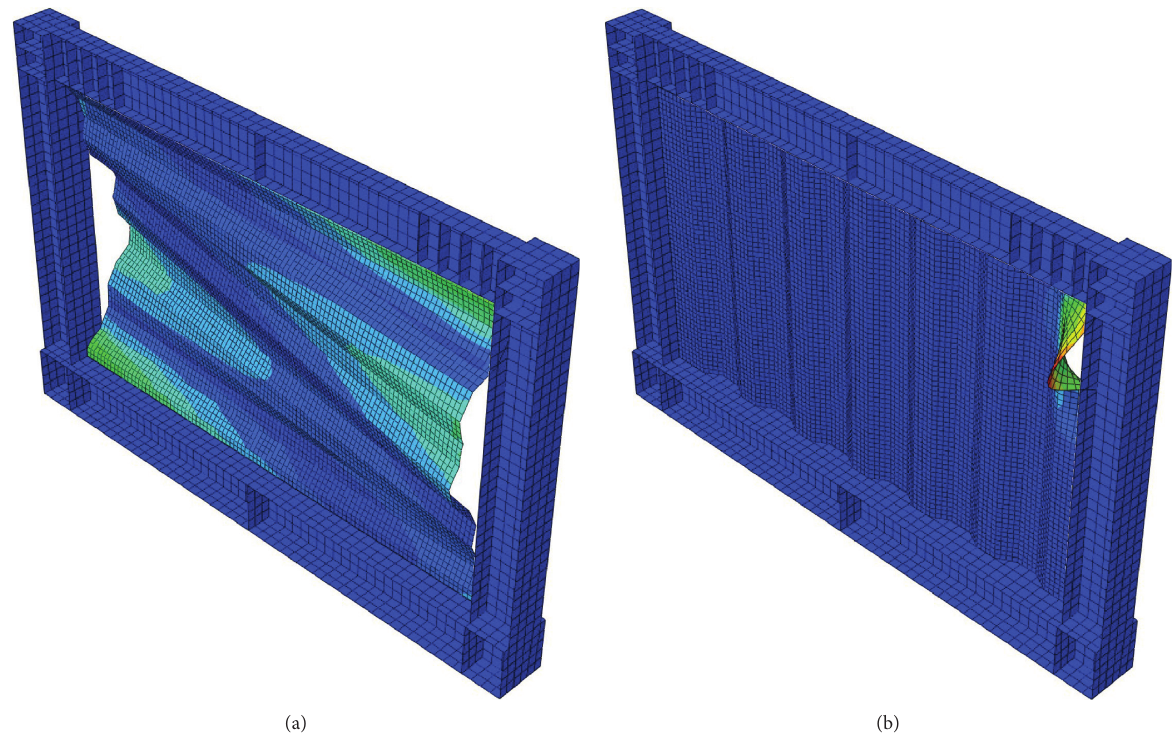
Figure 5: First mode shape of CSPSWs in the beam-only-connected state. (a) Horizontal CSPSW. (b) Vertical